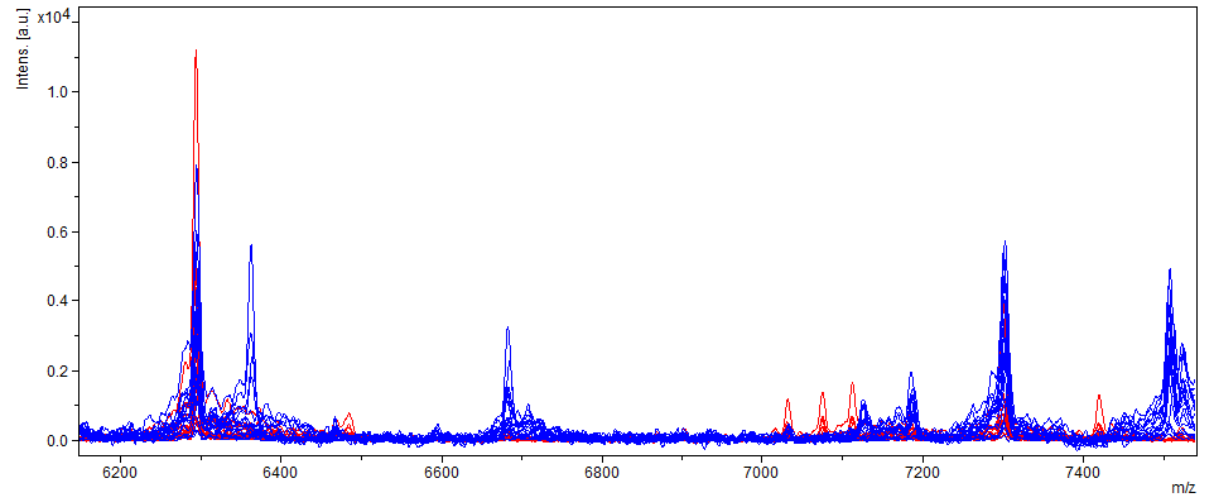
Figure 9. Differences in mass spectra detected in range of about 7000 and 7200 m/z from AFB 1 pro- ducing and non-producing strain of A. flavus , where blue spectra showed non-producers and red spectra producers.